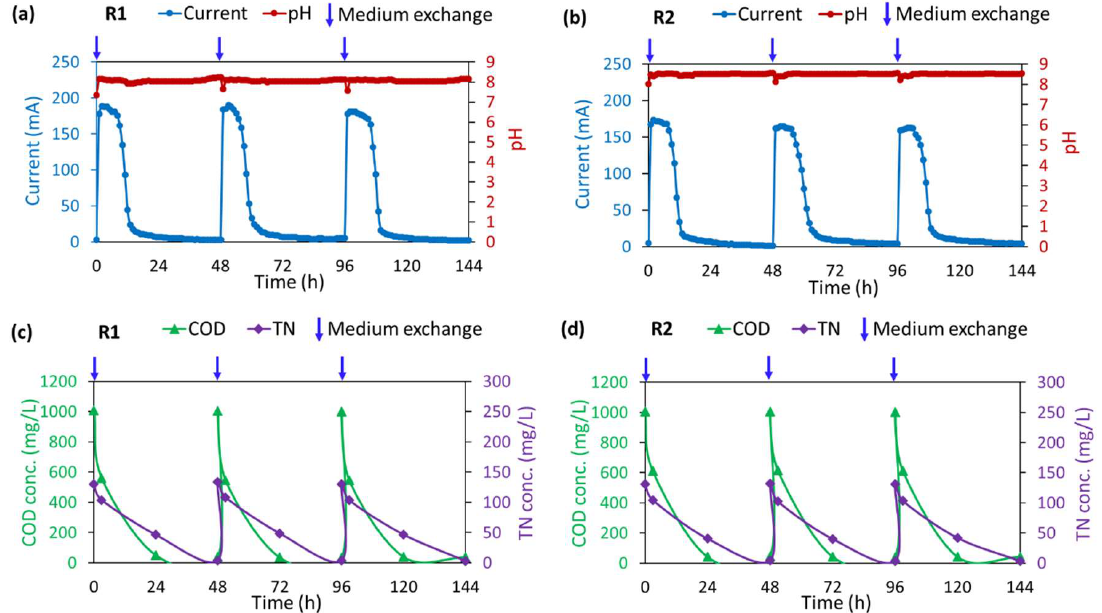
Figure 2. Representative profiles of current generation in the bioelectrochemical system-trickling filter (BES-TF) reactors ( a ) R1, and ( b ) R2. Variations in the levels of chemical oxygen demand (COD) and total nitrogen (TN) values in ( c ) R1, and ( d ) R2. Arrows indicate the time points at which medium exchange had occurred. Table 1. The coulombic efficiencies and decomposition efficiencies of chemical oxygen demand (COD) and total nitrogen (TN) in the two bioelectrochemical system-trickling filter (BES-TF) reactors, R1 and R2.